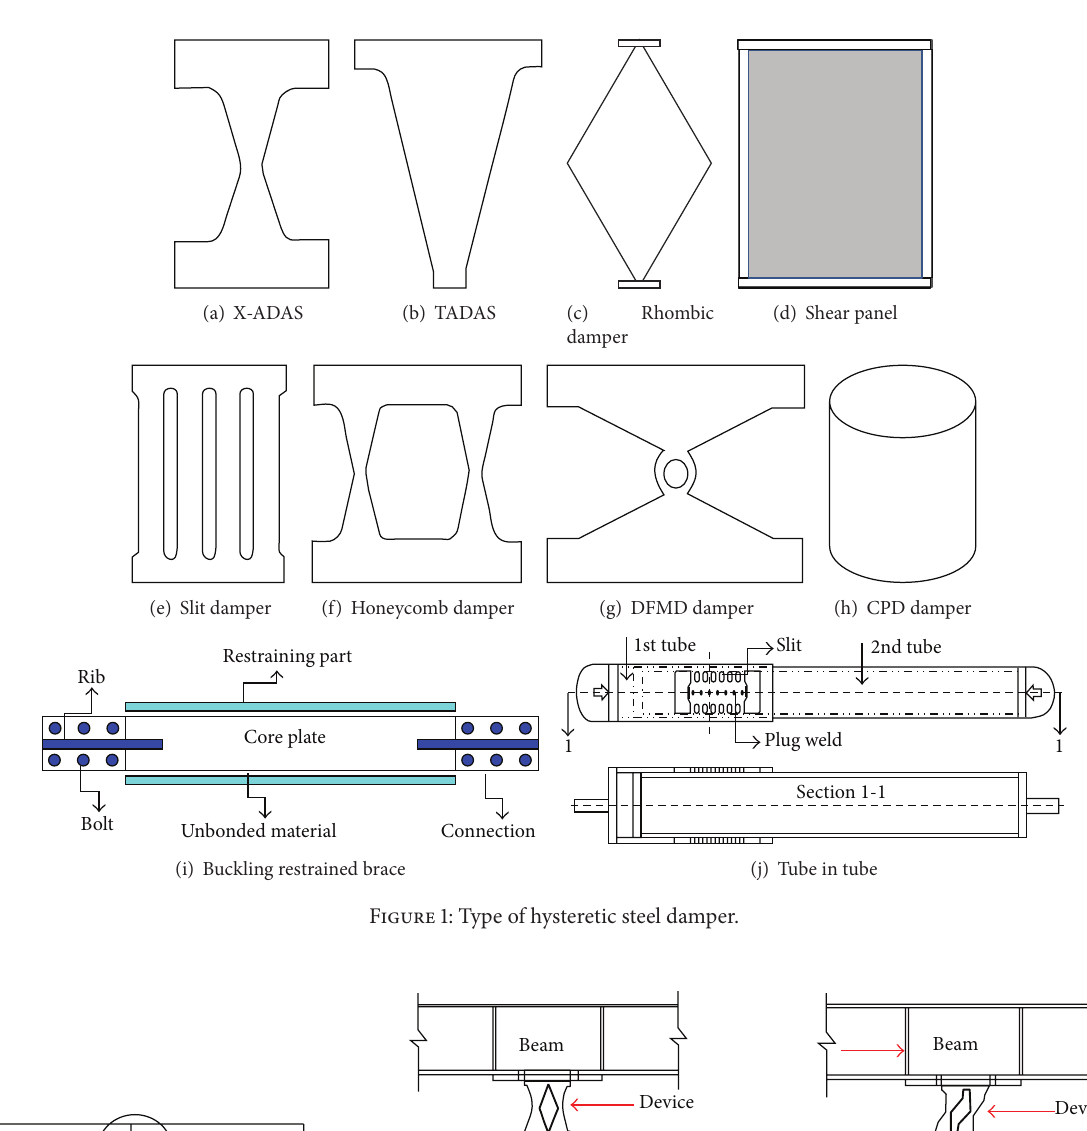
Figure 1: Type of hysteretic steel damper.